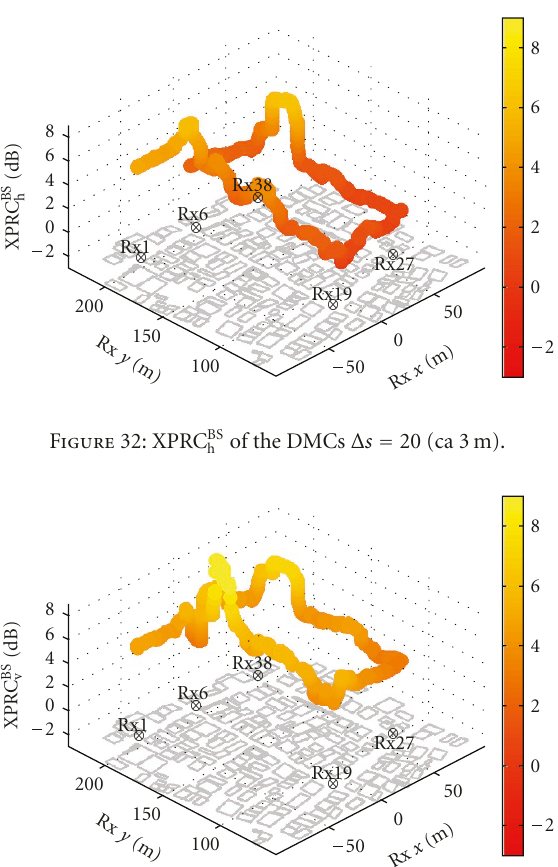
Figure 33: XPRC BS